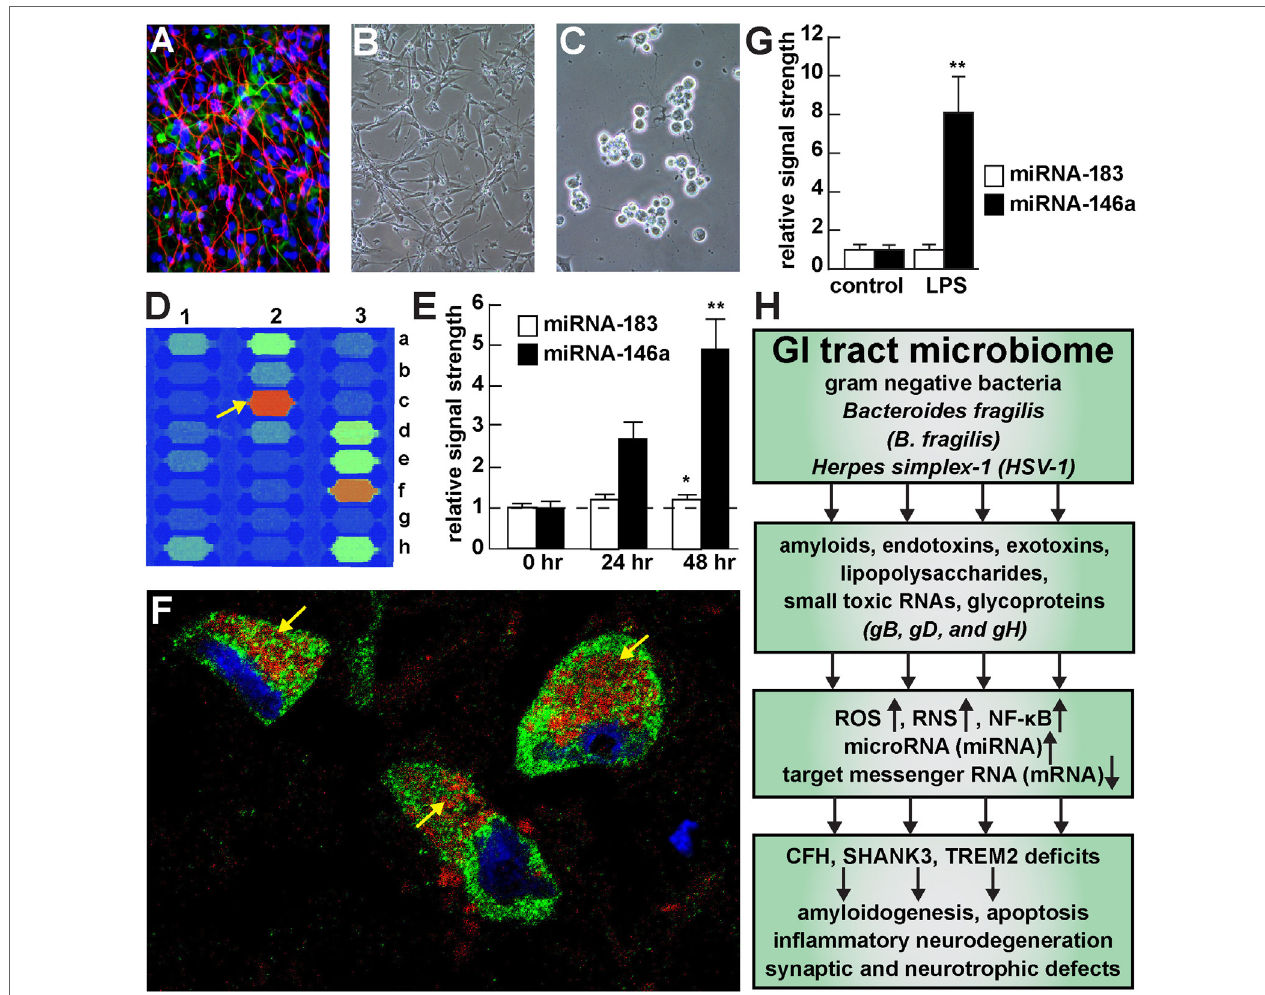
FiGUre 1 | Viral and bacterial contribution to neuroinflammatory signaling in sporadic Alzheimer’s disease (AD) brain— (A) primary human neuronal-glial (HNG) cells after ~2 weeks in primary coculture; the cell density is approximately 75% neurons and 25% astroglia at ~60% confluency; human primary neuronal and glial “support” cell cocultures are utilized because human neuronal cells do not culture well by themselves (11); neuronal cells are stained with neuron-specific β -tubulin (red; λ max = 690 nm), glial cells are stained with glial-specific glial fibrillary acidic protein (GFAP; green; λ max = 525 nm), and nuclei are stained with DAPI/Hoechst 33258 stain (blue; λ max = 470 nm); photo magnification 30 × ; (B) control HNG cells in primary culture; as in previous panel; light microscopy 30 × ; (c) HNG cells exposed to HSV-1 for 48 h; note “rounding up of cell bodies and retraction of neurites”; (D) miRNA array analysis of an overexpressed proinflammatory miRNA-146a in HSV-1 treated HNG cells; on this miRNA array an upregulated miRNA-146a is indicated at position 2c (33); (e) time course of induction (0, 24, and 48 h) of a pathogenic miRNA-146a in HNG cells by HSV-1; at 48 h the abundance of miRNA-146a was almost fivefold over controls; miRNA-183 represents an unchanging miRNA control; (F) association of lipopolysaccharide (LPS) with the neuronal cytoplasm and the periphery of neuronal nuclei in AD neocortex—NeuN (neuron- specific green stain; λ max = 520 nm), LPS (red stain; λ max = 690 nm), and DAPI (blue stain; λ max = 470 nm); human superior temporal lobe AD neocortex (Brodmann A22); note organization of LPS into a “clathrin-like” lattice or “net” within the neuronal cell cytoplasm (yellow arrows); (G) induction of the proinflammatory miRNA-146a in LPS-stressed HNG cells is almost eightfold over controls after 48 h; (H) flow chart of the potential contribution of the GI tract-resident microbiome- abundant Gram-negative bacilli Bacteroides fragilis and herpes simplex-1 (HSV-1) to neuropathological pathways; stressed B. fragilis secrete a remarkable quantity of neurotoxins that include amyloids, endotoxins, exotoxins, LPS, and small toxic microRNA-like RNAs; upon HSV-1 invasion of human neurons cell surface proteins serve as receptors for viral entry and the HSV-1 glycoproteins gB, gD, and gH are required for infection of, and the maintenance of latency in human neurons; in both cases B. fragilis and HSV-1 in turn induce the evolution of reactive oxygen species (ROS), reactive nitrogen species (RNS), and the proinflammatory transcription factor NF- κ B and upregulate a small family of NF- κ B-sensitive microRNAs (miRNAs) including miRNA-146a that interact with the 3 ′ -untranslated region (3 ′ -UTR) of messenger RNA (mRNA) targets (1, 36, 37). In the case of B. fragilis signaling this drives the downregulation of complement factor H (CFH), the postsynaptic cytoskeletal SHANK3 and the triggering receptor expressed in myeloid/microglial cells TREM2; deficits in CFH, SHANK3, and TREM2 resulting in the inability to clear excessive amyloid from brain cells, amyloidogenesis, apoptosis, inflammatory neurodegeneration and synaptic and neurotropic deficits. Because all miRNA fractions were obtained from short postmortem interval (PMI) human tissue samples and miRNAs have been reported to have a high rate of depolymerization (degradation) under physiological, and especially pathophysiological conditions, only upregulated miRNAs were studied here; in fact miRNA upregulation and mRNA downregulation appears to be a very common posttranslational genetic regulatory mechanism in the human and murine CNS [see text (38, 39)]. Note that parts of Figure 1 have been considerably updated from a previous version (37,